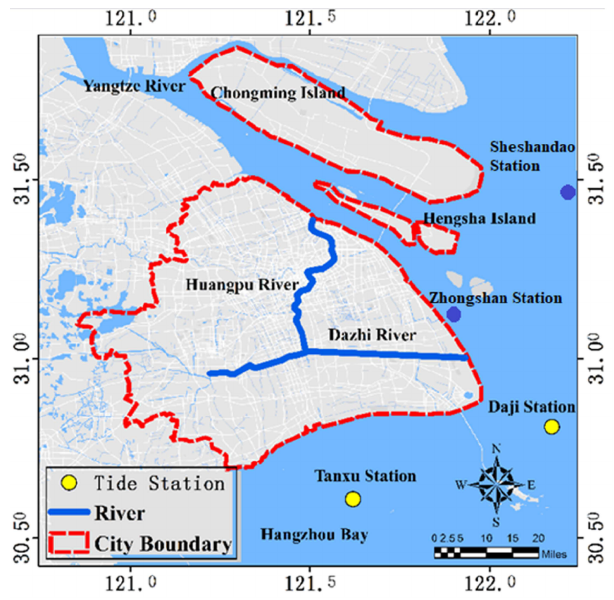
Figure 2. Local map of Shanghai with the dashed red line indicating the city’s political boundary and simulation area, while the blue line indicates the Huangpu and Dazhi rivers. The yellow points represent two tide gauges used to calibrate the models, while the blue points represent tide gauges used for tide validation. Sources: Esri, De- Lorme, HERE, USGS, Intermap, iPC, NRCan, Esri Japan, METI, Esri China (Hong Kong), Esri (Thailand), MapmyIndia and Tom-